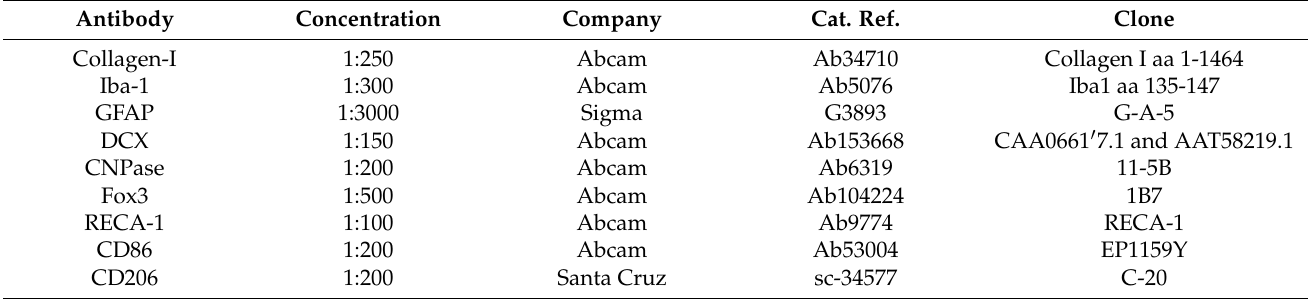
Table 2. List of antibodies used for